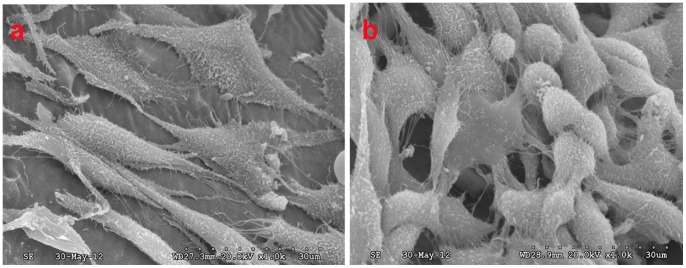
SEM micrographs of the MC3T3-E1 cells cultured on the n-HA/PA/GF scaffold.(a) Long, spindle-shaped cells attached to the walls of the scaffold after 3 days (SEM×1000). (b) A confluent layer of cells proliferated on the scaffold after 7 days (SEM×1000).